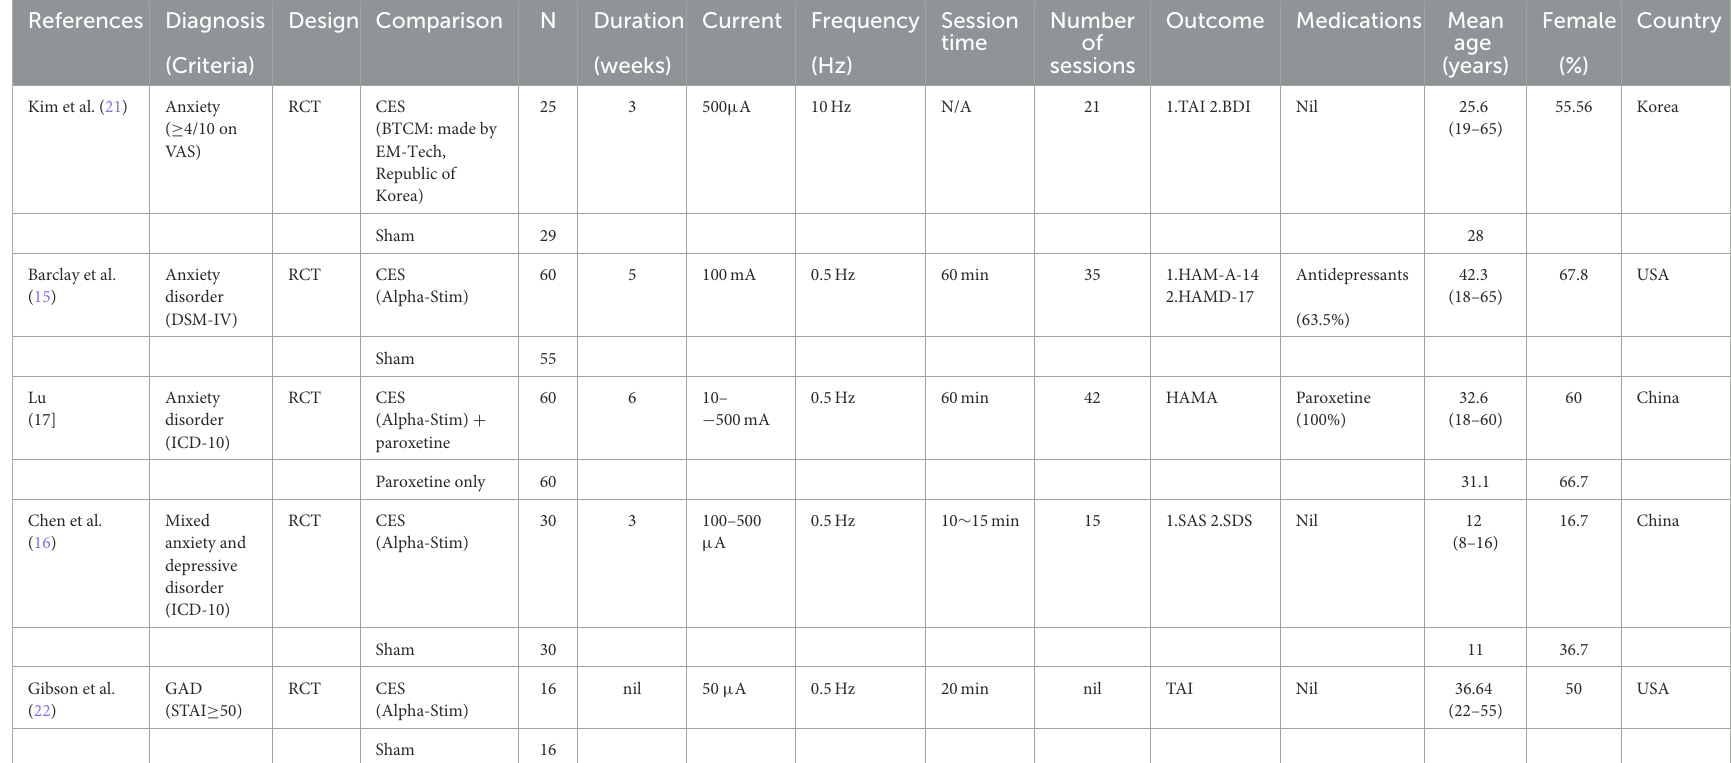
TABLE 1 Summary of characteristics of studies in the current